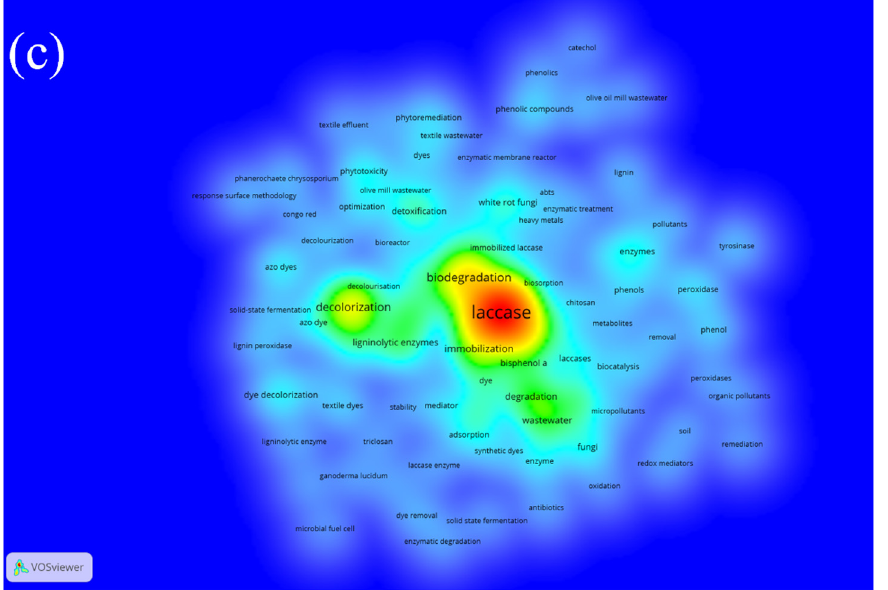
Figure 6. ( a ) Network Visualization of keywords’ co-occurrences (weights: occurrences). ( b ) Overlay visualization of keywords’ co-occurrences in 2002–2022 (weights: occurrences; scores: average publications per year). ( c ) Density visualization of keywords’ co-occurrences (weights: occurrences).